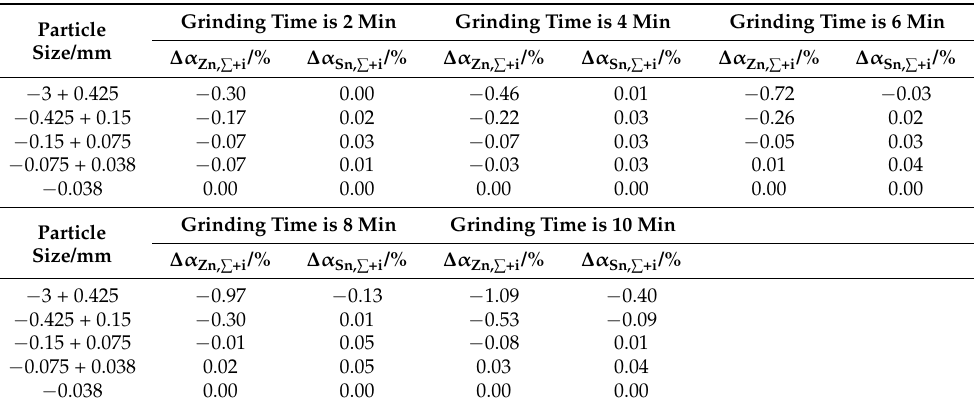
Table 4. Changes in the cumulative grade for different grinding